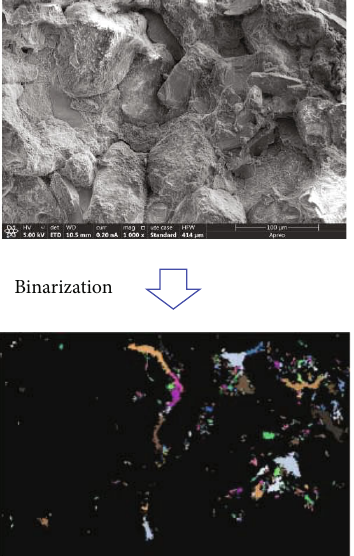
Figure 12: Binary image of fracture surface on sandstone sample.